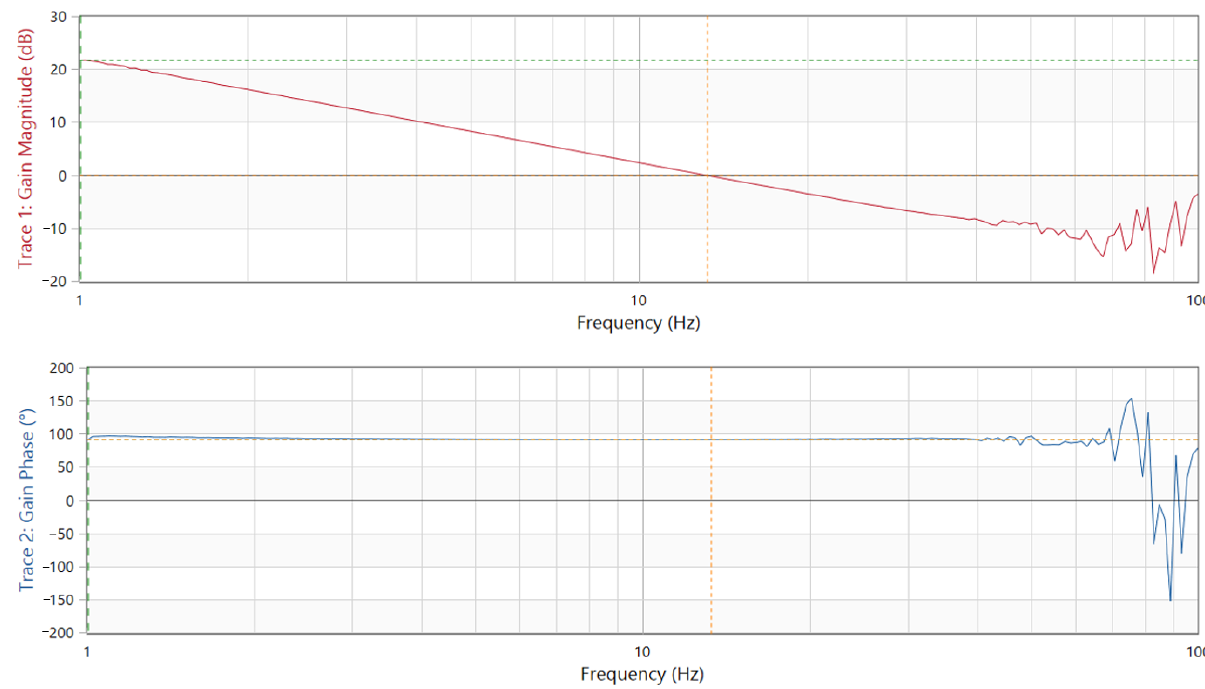
Figure 25. Loop gain test result of VOT control scheme with 110 Vac and rated output current load.